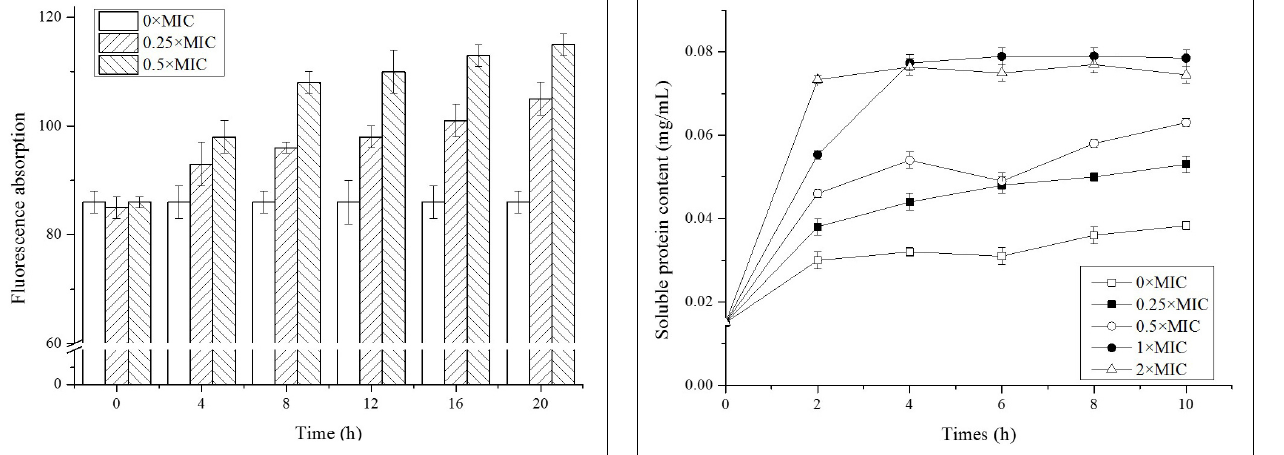
FIGURE 3 | Soluble protein content of Salmonella exposed to different doses of